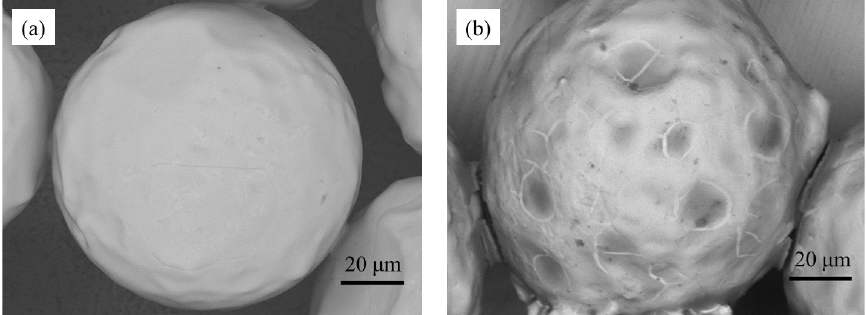
Figure 6. SEM images of Cu particles: ( a ) uncoated and ( b ) coated.